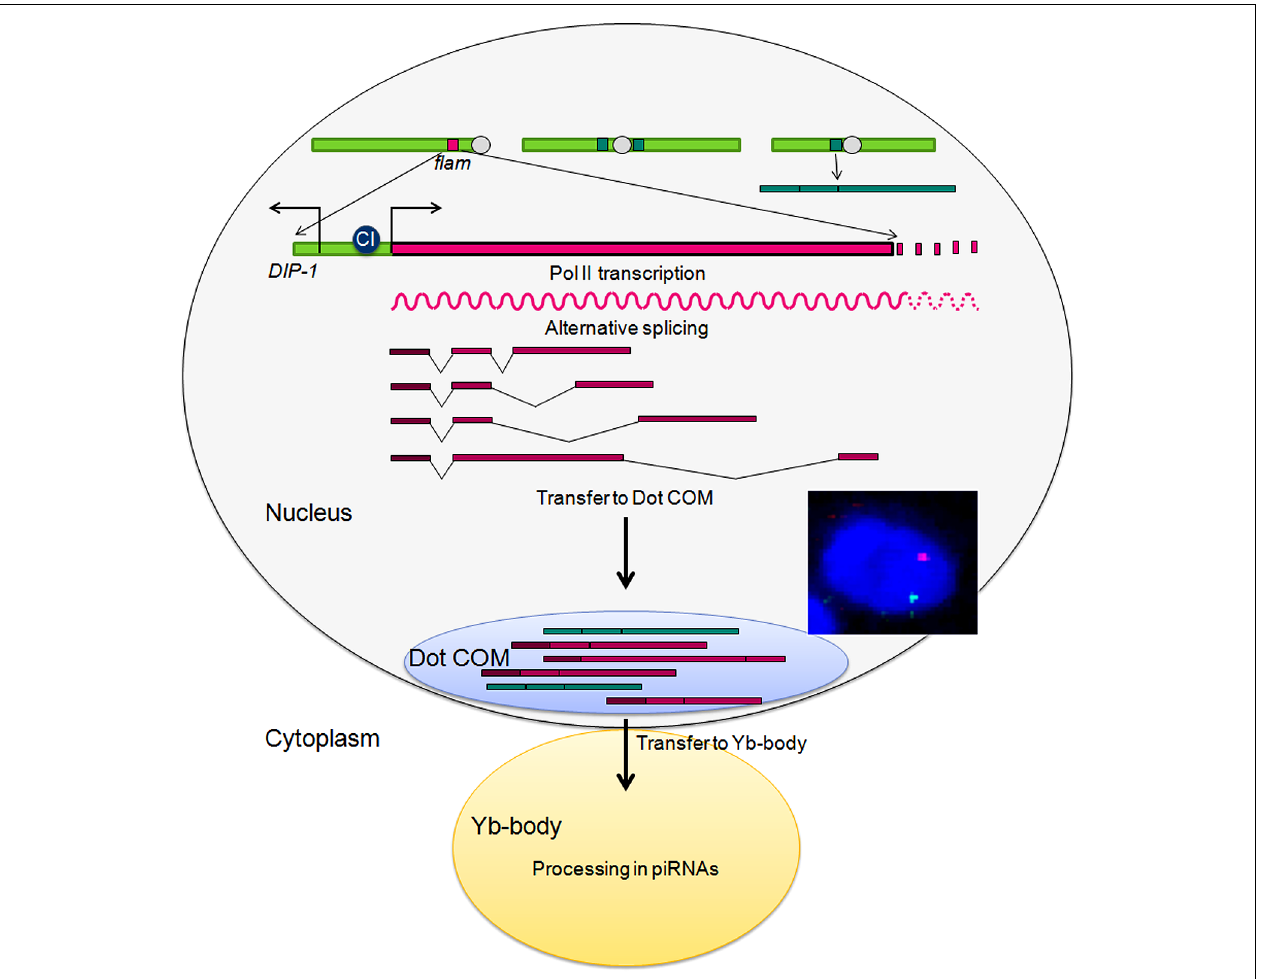
FIGURE 4 | Model of the piRNA pathway in the follicle cells of Drosophila ovaries. A typical DNA/RNA immunoFISH staining with flam RNA in green, flam DNA in red, and DNA in blue is